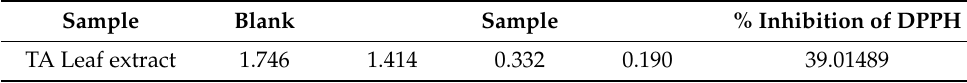
Table 6. DPPH scavenging